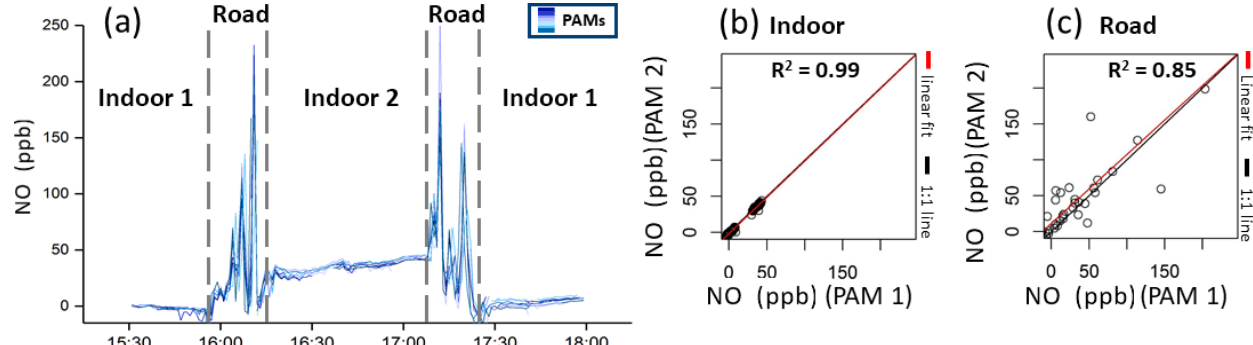
Figure 5. Short-term deployment of nine PAMs carried simultaneously by a pedestrian moving between two indoor environments (laboratory, café) in Cambridge, UK, in January 2018. (a) Time series of NO measurements from the PAM sensors (blue lines). (b, c) Scatterplots between two of those PAMs, whereby indoor data were separated from outdoor data. The 1:1 line is in black, and the linear fit line is in